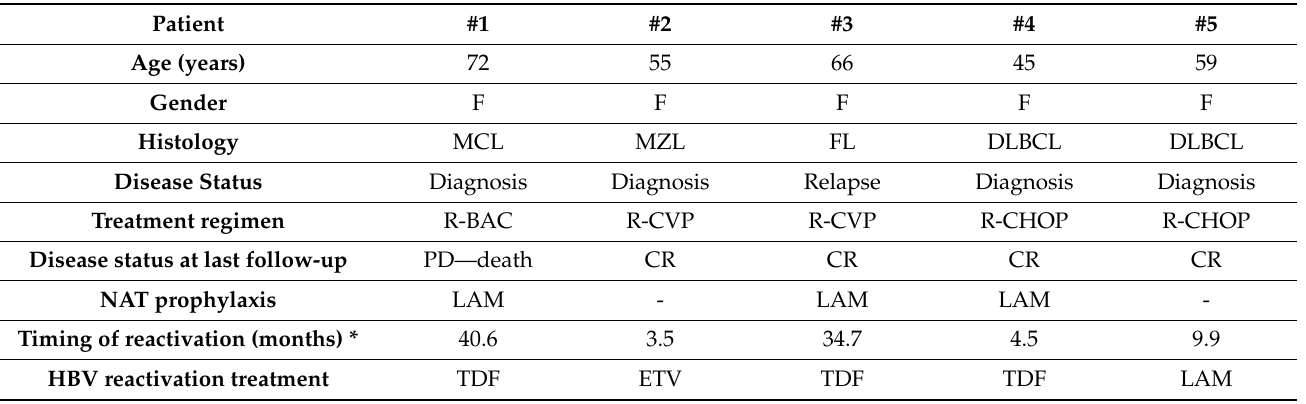
Table 3. Characteristics of reactivated patients ( n = 5).